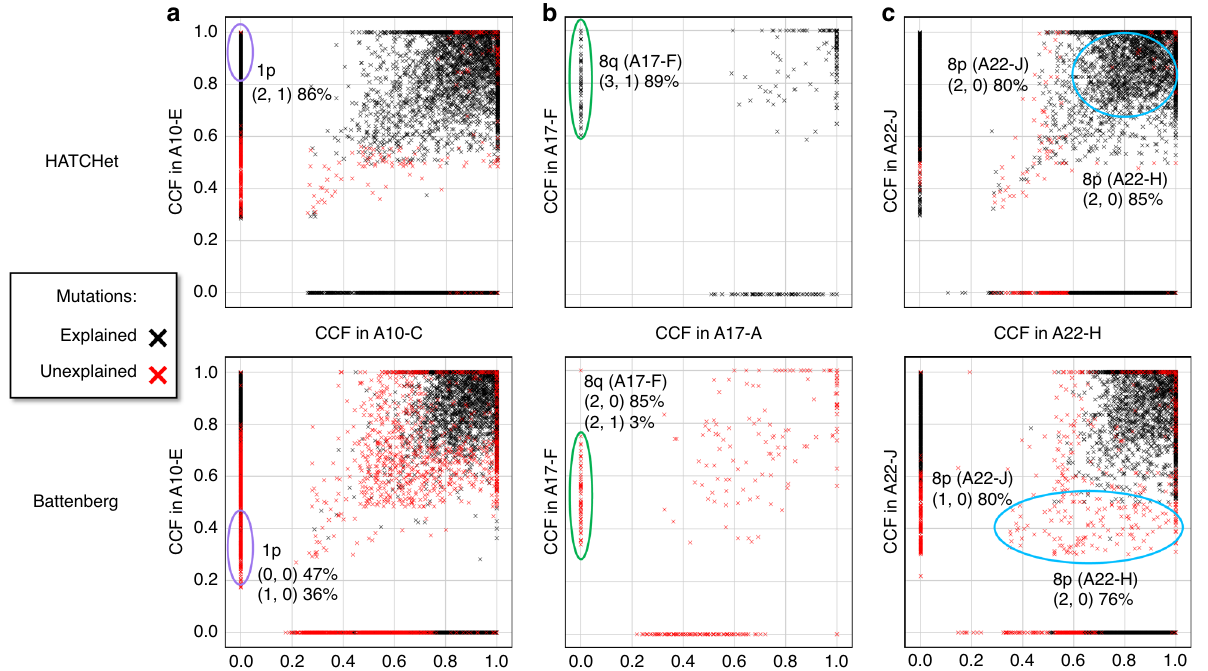
Fig. 7 HATCHet copy numbers improve estimates of CCFs of somatic mutations in prostate cancer patients. a CCFs of somatic SNVs and small indels in samples A10-C and A10-E of patient A10 computed from allele-speci fi c copy numbers and proportions inferred by HATCHet (top) and Battenberg (bottom). HATCHet explains a substantial number of mutations that are unexplained by Battenberg; for example, HATCHet infers a clonal CNA on chromosome 1p in A10-E and determines that the mutations at this locus (purple circle) are clonal (i.e., CCF ≈ 1). In contrast, Battenberg infers subclonal CNAs at the same locus, and determines that the same mutations are subclonal (CCF ≈ 0.3). b CCFs of somatic SNVs and small indels in samples A17-A and A17-F of patient A17 show groups of mutations that are explained by HATCHet and unexplained by Battenberg (only this subset of mutations is shown here for simplicity). For example, HATCHet infers a clonal CNA on chromosome 8q in A17-F and suggests that mutations in that region (green circle) are clonal (CCF ≈ 1), while Battenberg infers subclonal CNAs and suggests that the same mutations are subclonal (CCF ≈ 0.5). c CCFs of somatic SNVs and small indels in samples A22-J and A22-H of patient A22 show a large group of shared mutations on chromosome 8p (cyan circle with CCF > 0 in both samples). HATCHet infers the same copy-number state (2, 0) in both samples, explains these mutations, and suggests that they are clonal. Battenberg infers distinct copy-number states (1, 0) and (2, 0) in the two samples, leaves these mutations unexplained, and suggests that the mutations are subclonal in both